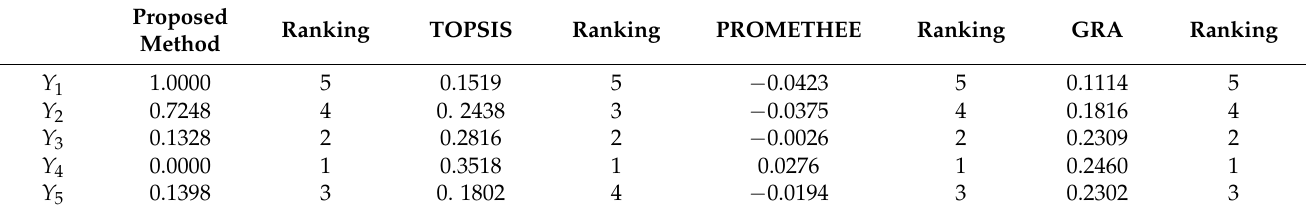
Table 3. Ranking results of diverse MCDM